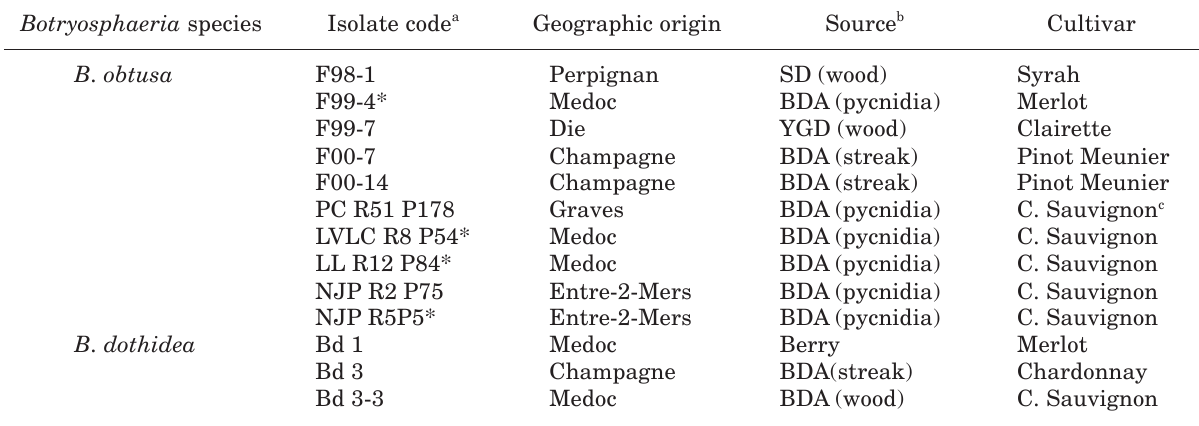
Fig. 1. Symptoms of the severe form of black dead arm on Cabernet Sauvignon. a) Dieback of shoots. b) After premature leaf fall, a few leaves remain clinging to the Table 1. Sources of Botryosphaeria obtusa and Botryosphaeria dothidea used for pathogenicity tests. Botryosphaeria species